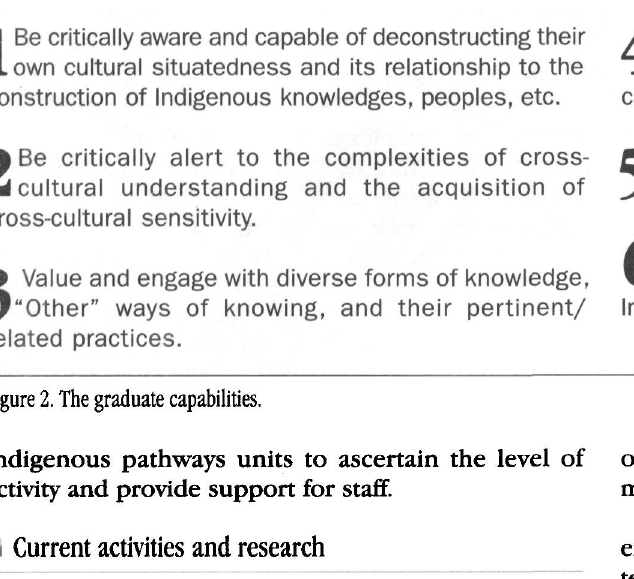
Figure 2. The graduate